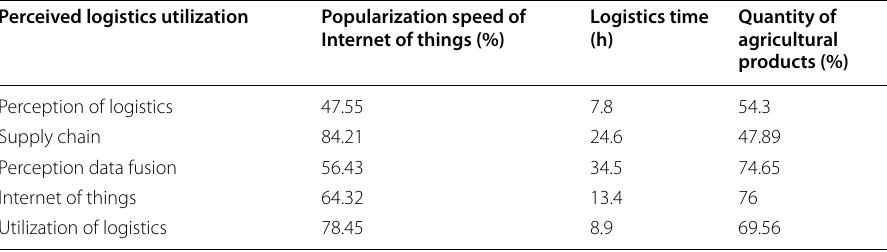
Perceived logistics utilization Popularization speed of Internet of things